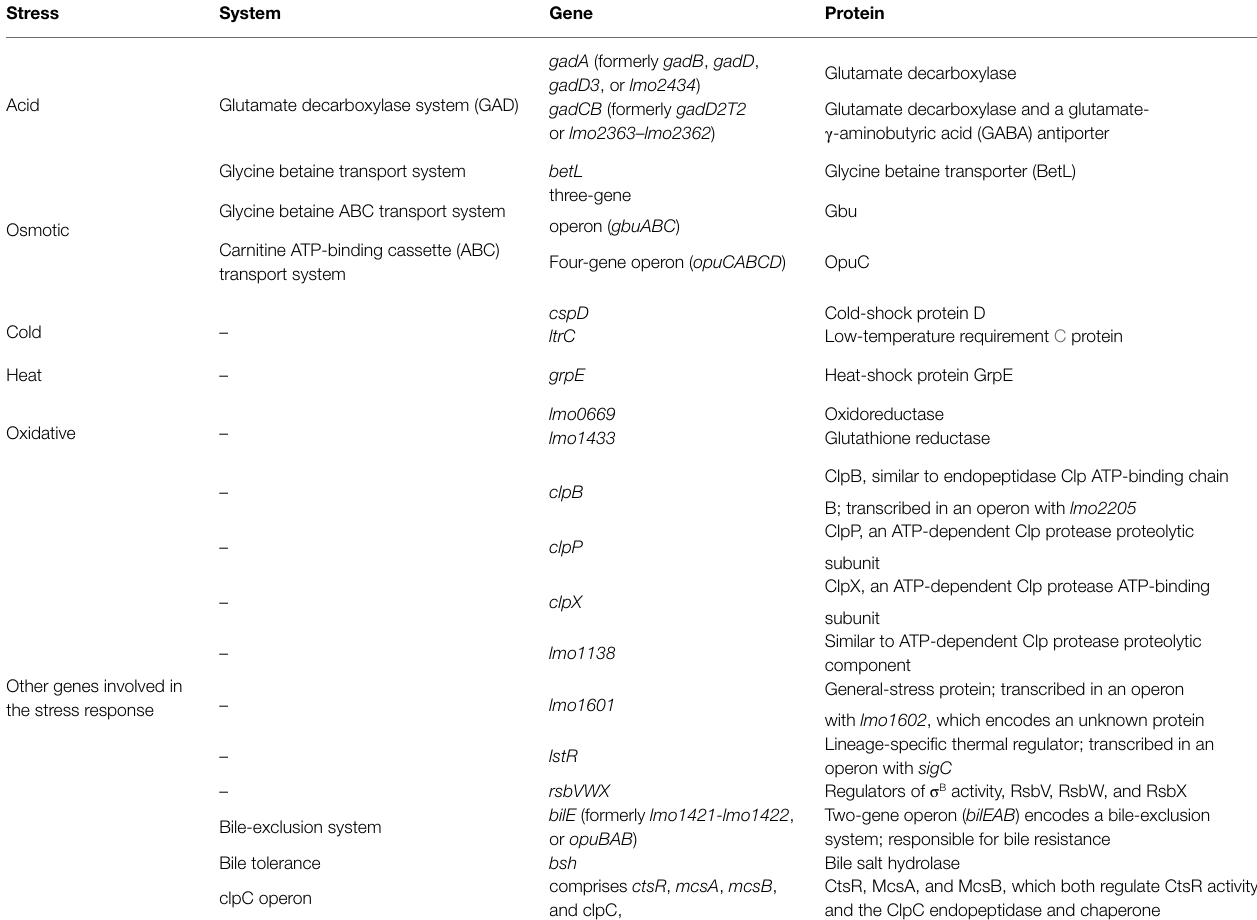
TABLE 2 | Listeria monocytogenes stress-response and virulence genes and proteins.